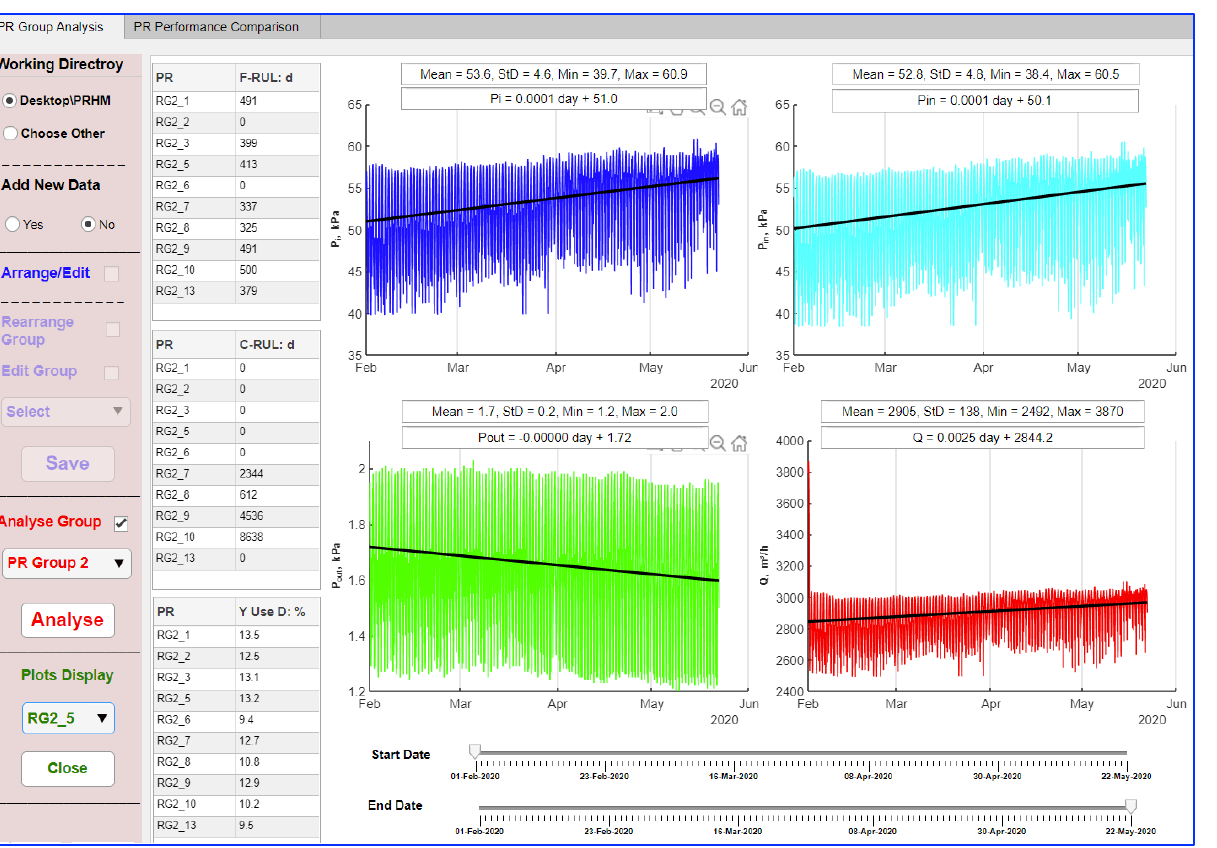
Figure 7. The GUI for the PR health monitor dashboard showing the estimated RUL values for the filter and valve seat, the annual diaphragm usage, and the pressure and flow plots. filter and valve seat, the annual diaphragm usage, and the pressure and flow